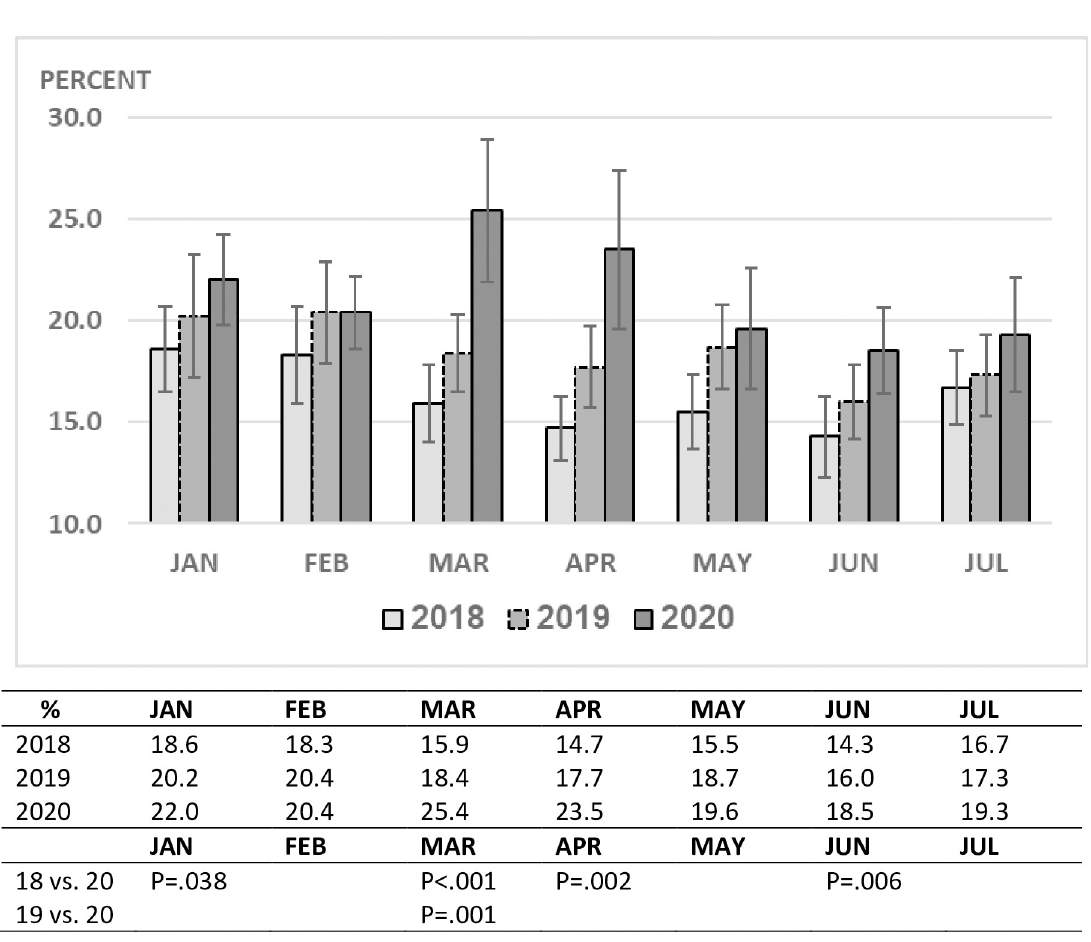
Fig 4. PED hospitalization rate by month and